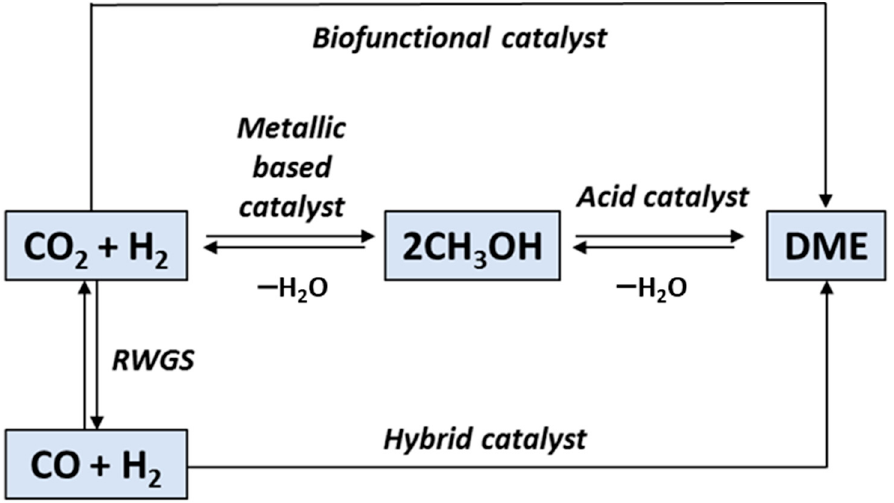
Figure 13. General scheme for the synthesis of DME by direct hydrogenation of CO 2 with hybrid or bifunctional catalysts.